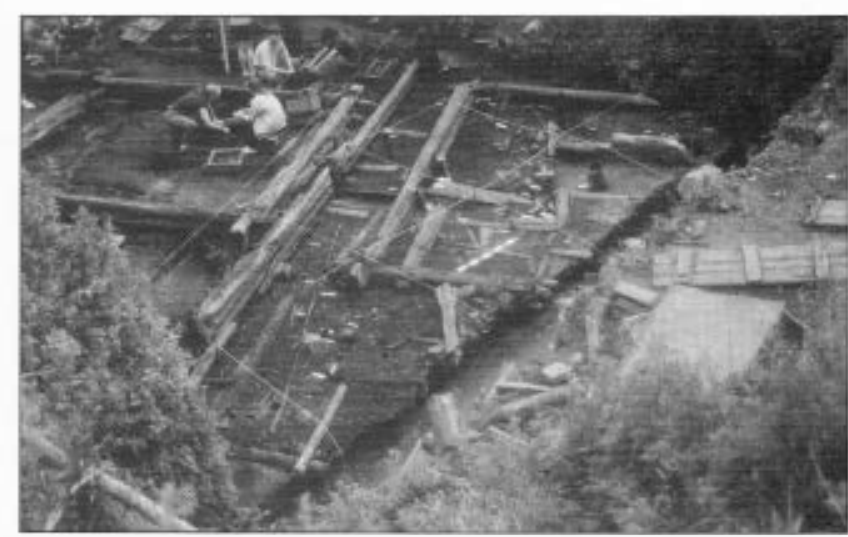
Figure 3 The mid-tenth-century building excavated by the UCL team in Troitsky XI; view from the northwest after removal of the plank floor (scale bar intervals 10cm).